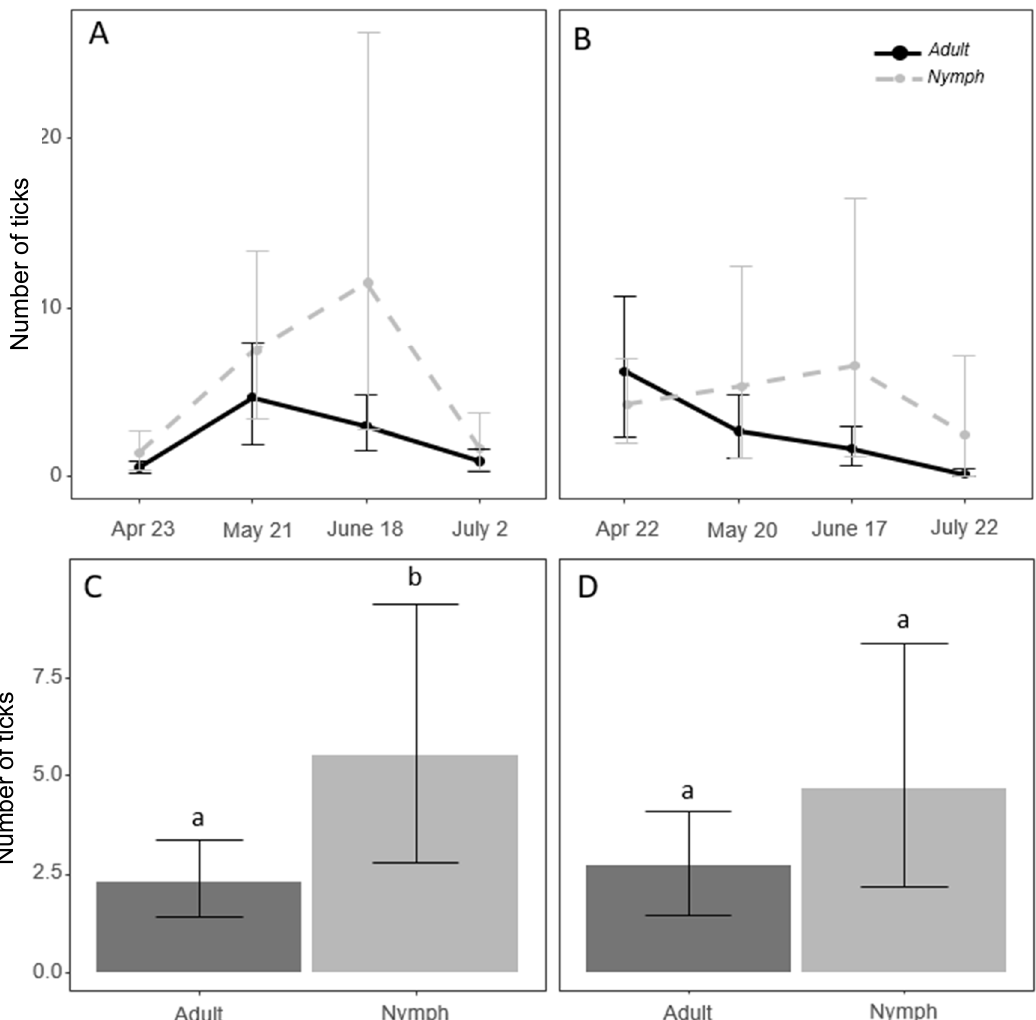
Figure 1. Average number of Amblyomma americanum adults and nymphs sampled during each week of sampling in 2018 ( A ) and 2019 ( B ). The yearly average abundance of adults and nymphs sampled in 2018 ( C ) and 2019 ( D ). Means with the same letter are not significantly different. (Tukey’s Honestly Significant Difference) ( p < 0.05).